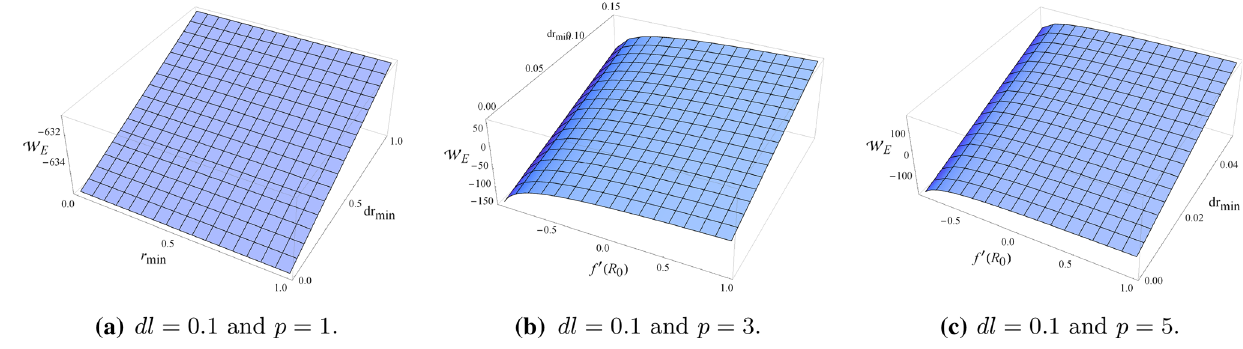
Fig. 4 The value of W E for Q = 2, l = 1, (cid:4) D − 2 =